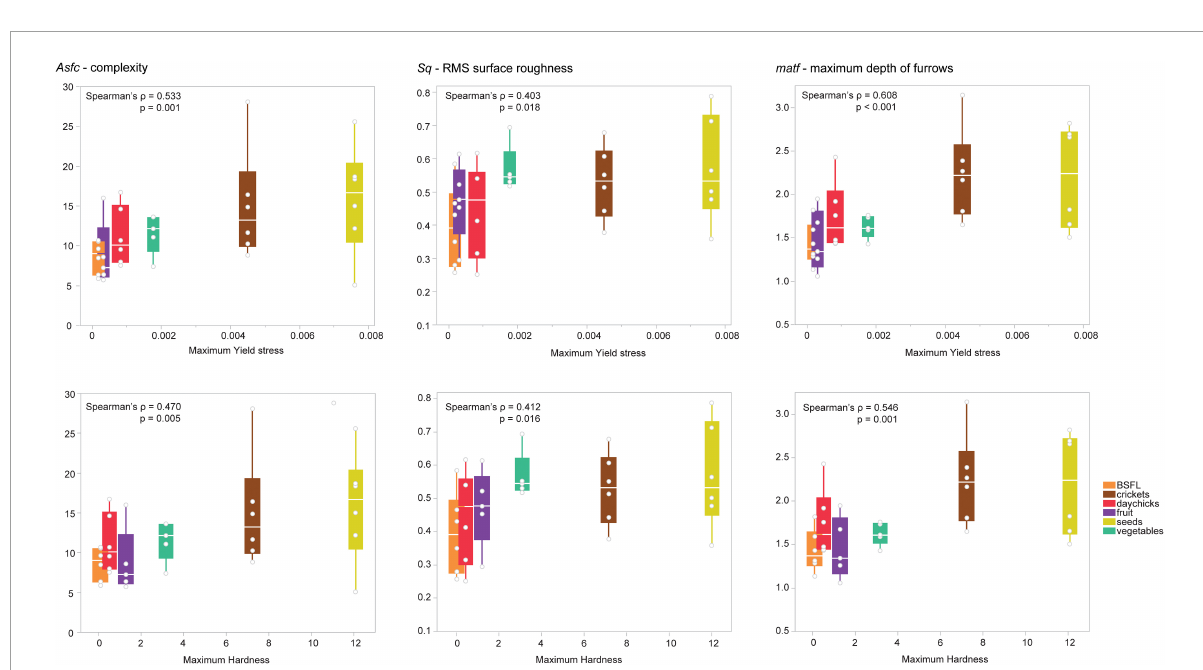
FIGURE5 Correlations of selected DMTA parameters were obtained from the second upper molar (M2) of all rat diet groups for maximum yield stress and maximum TPA hardness. The upper row shows a correlation with maximum yield stress per diet, and the lower row shows a correlation with maximum TPA hardness per diet. BSFL, black soldier fly